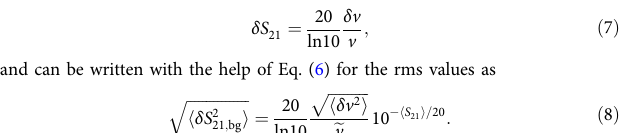
Fig. 5 Background noise measurements. All the data are taken outside the zero bias regime of the thermometer and at nonresonant frequencies to exclude the actual noise from the sample. The inset of a shows an example of h S 21 i measured around the resonance frequency indicated by the central upward arrow. The blue dots in the main frame of a depict parametric plot ffiffiffiffiffiffiffiffiffiffiffiffiffiffiffiffi q versus h S at the bias voltages V 85 µ V and at frequencies h δ S 2 21 ; i 21 i th ¼ bg below the resonance down to 614 MHz indicated by a downward arrow. The red solid line shows the predicted dependence of Eq. (8) yielding the noise temperature of the ampli fi er of T 4 : 9 K as the only fi t parameter of the n ¼ curve (constant noise voltage at the input). b The full range measurement of the background as in a but now both above and below the resonance with red and blue dots, respectively. The polynomial fi ts for the two backgrounds separately (black dashed lines) and the average of them (green solid line) are shown, and they de fi ne the mean and the shaded area in Fig. 3. The inset of b is simply the zoom-out of the high attenuation range of the main